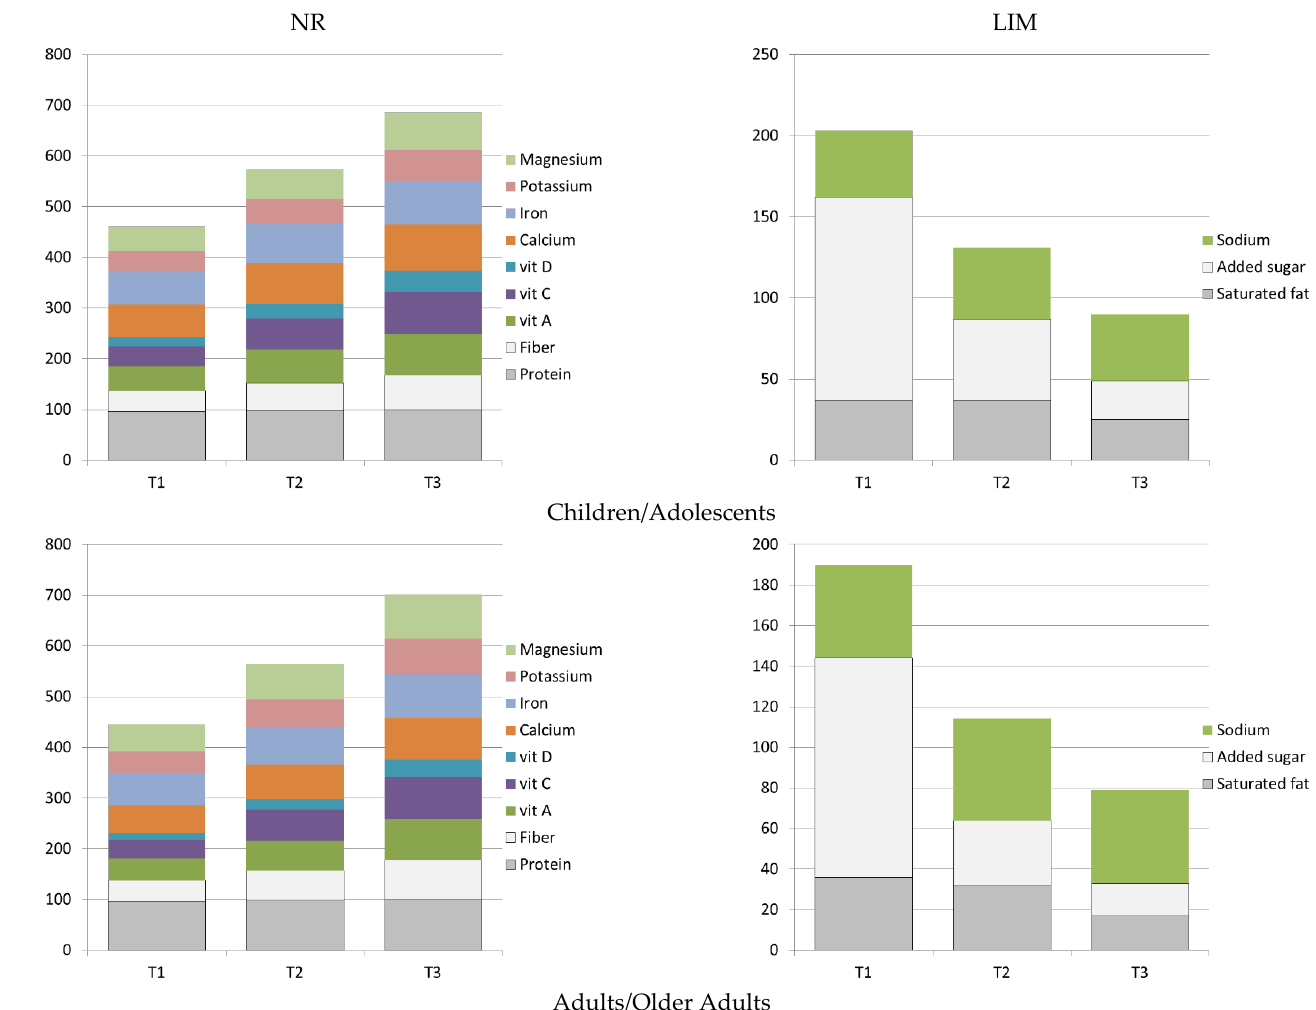
Figure 3. Nutrient subscores of the Nutrient Rich Index (NRF9.3) by age group and by tertiles of total NRF9.3 scores.